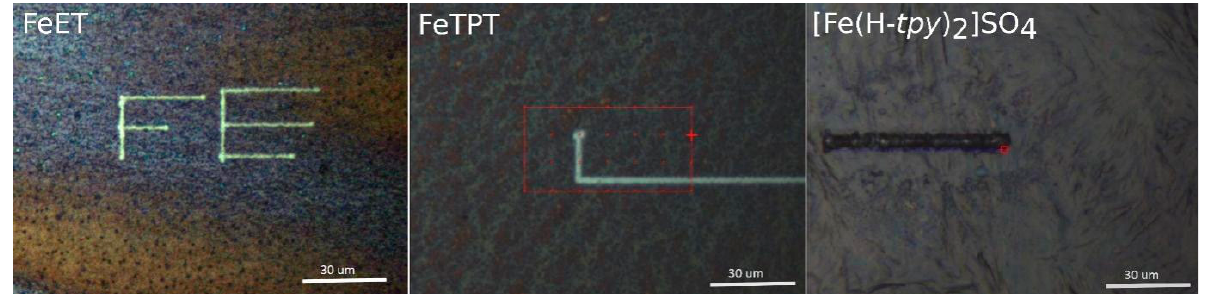
Figure 9. Optical microscopy images of films of two phosphole Fe-MSPs and [Fe(tpy) 2 ]SO 4 showing traces drawn by a 532 nm laser beam with a power of 5 mW.